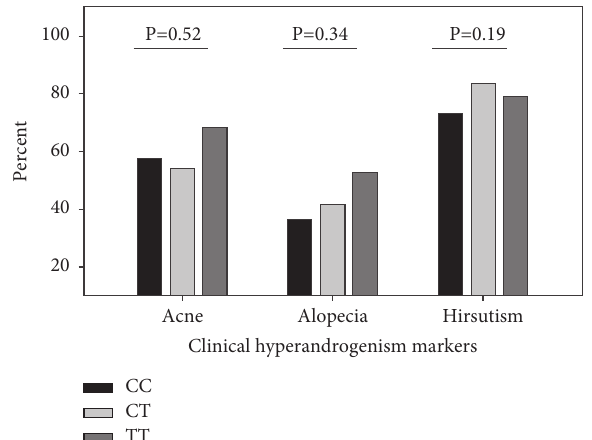
Figure 2: Comparison of INSR C/T SNP (rs1799817) genotypes with the presence of clinical manifestations of hyperandrogenism, acne, alopecia, and hirsutism in PCOS women. P value of CC vs. CT vs. TT calculated by Pearson chi-square test.